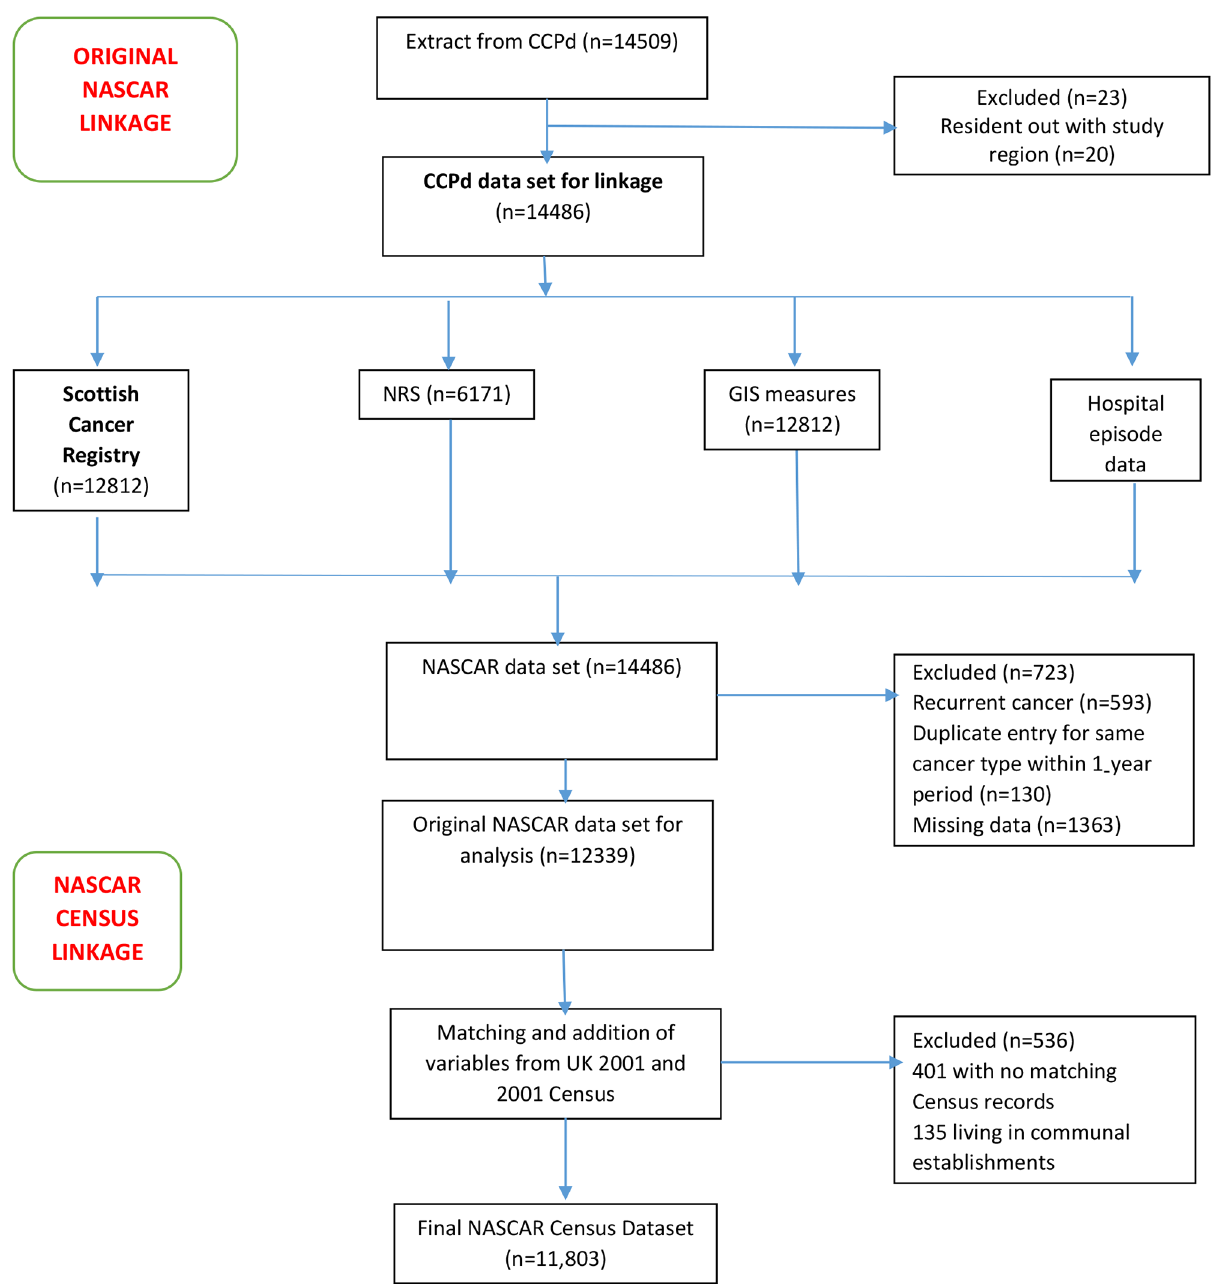
Figure 1: Flow diagram of study